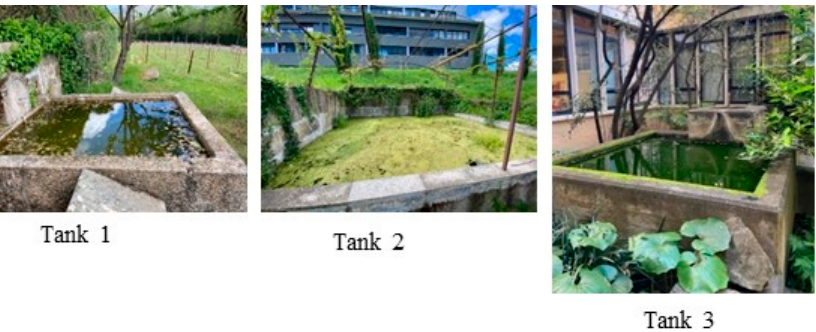
Figure 1. Visual aspect of the three tanks in the University Campus UTAD. Tanks 1 and 3 are to the north and northeast, and tank 2 to the oriented to the north and northeast, and tank 2 to the east.